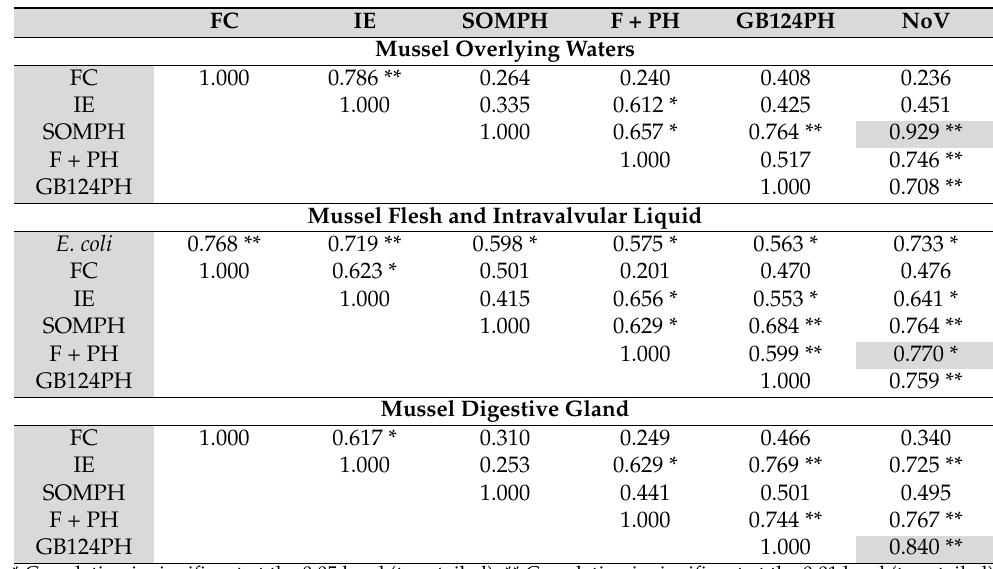
Table 4. ‘Autumn/winter’ correlation coefficients (Spearman’s ρ ) between faecal indicators and Norovirus with respect to mussel sample